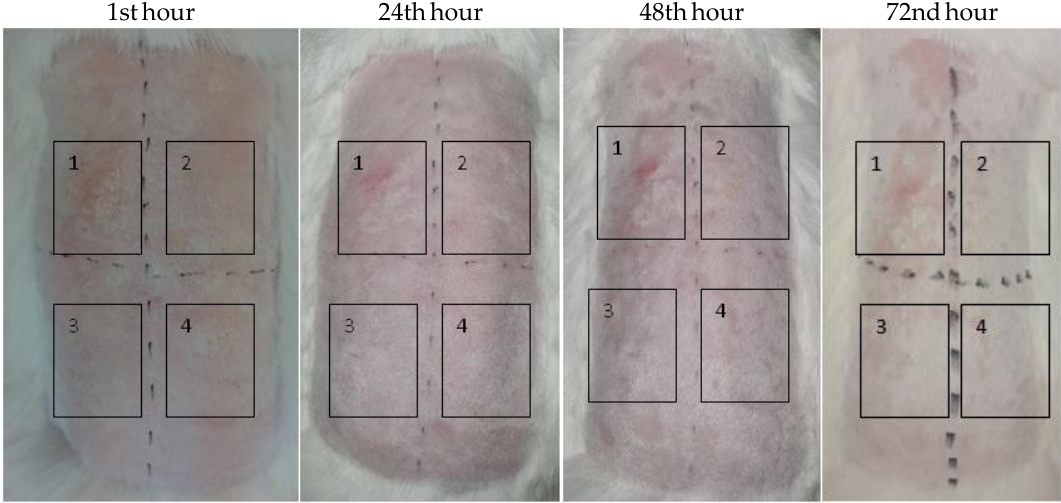
Figure 8. Skin irritation test — pictures of the experimental animals at the 1st, 24th, 48th and 72nd hour from the application of the patches. Legend: (1) 20 % SDS in PBS; (2) empty hydrogel; (3) OrO-NP-HG (0.0625%)/CN-HG (0.0625 mg/L); (4) osmotic solution of 0.9 % NaCl. The time interval is given in hours.